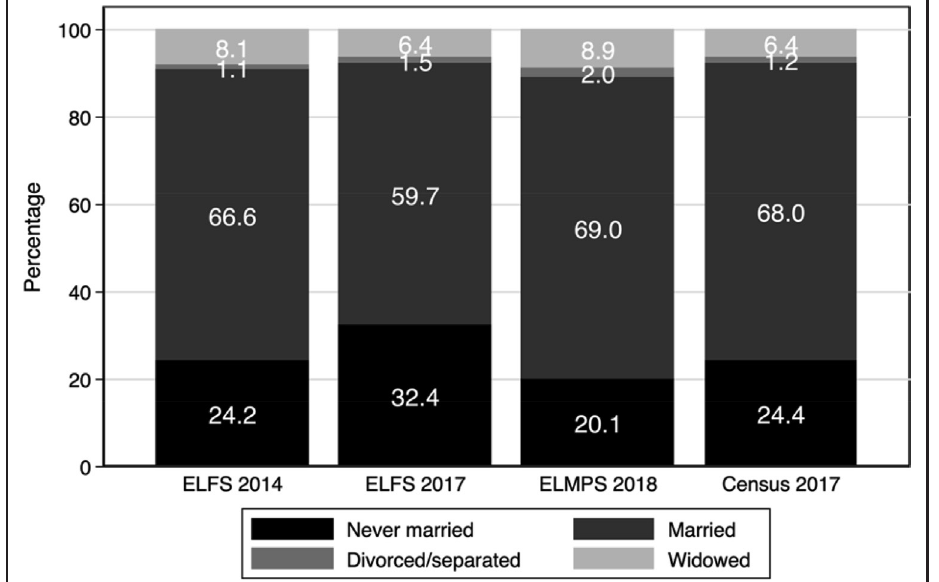
Table 1–2 (CAPMAS, 2017). CAPMAS, Central Agency for Public Mobilization and Statistics; ELMPS, Egypt Labor Market Panel Survey; LFS, Labor Force Figure 6 Marital status (percentage of individuals aged ≥ 18 years), by data source.